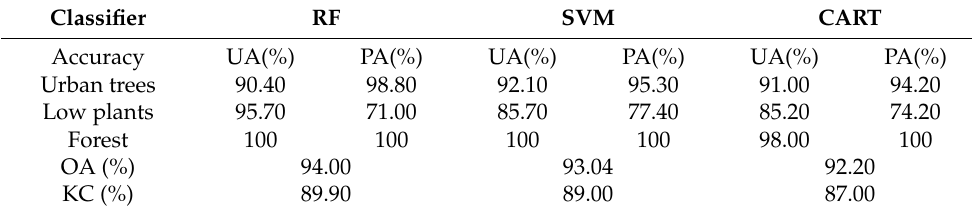
Table 3. Accuracy assessment of different machine learning classifiers.